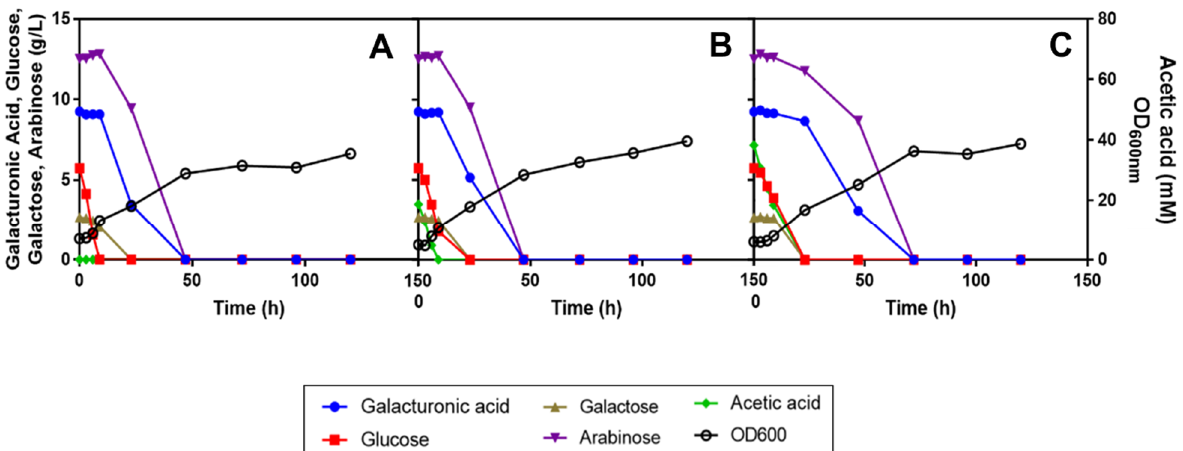
Figure 4. Effect of increasing concentrations of acetic acid (0 ( A ), 20 ( B ) and 40 mM ( C )) added to the synthetic SBP hydrolysate with the mixture of sugars in commercial YNB (with ammonium sulphate and amino acids) at pH 5.0 in R. toruloides PYCC 5615 growth and sugar utilization. All cultures were inoculated with an initial OD 600 nm of 4 and cultivation was carried out at 30 °C with orbital agitation (250 rpm).